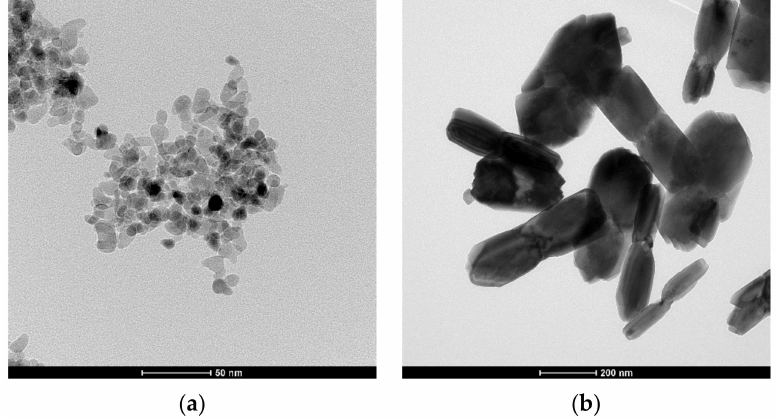
Figure 3. TEM micrographs of the powders crystallized under hydrothermal conditions: ( a ) Y 2 O 3 - ZrO 2 powder crystallized under hydrothermal conditions in water; ( b ) pure zirconia powder crystal- lized in an NaOH solution.